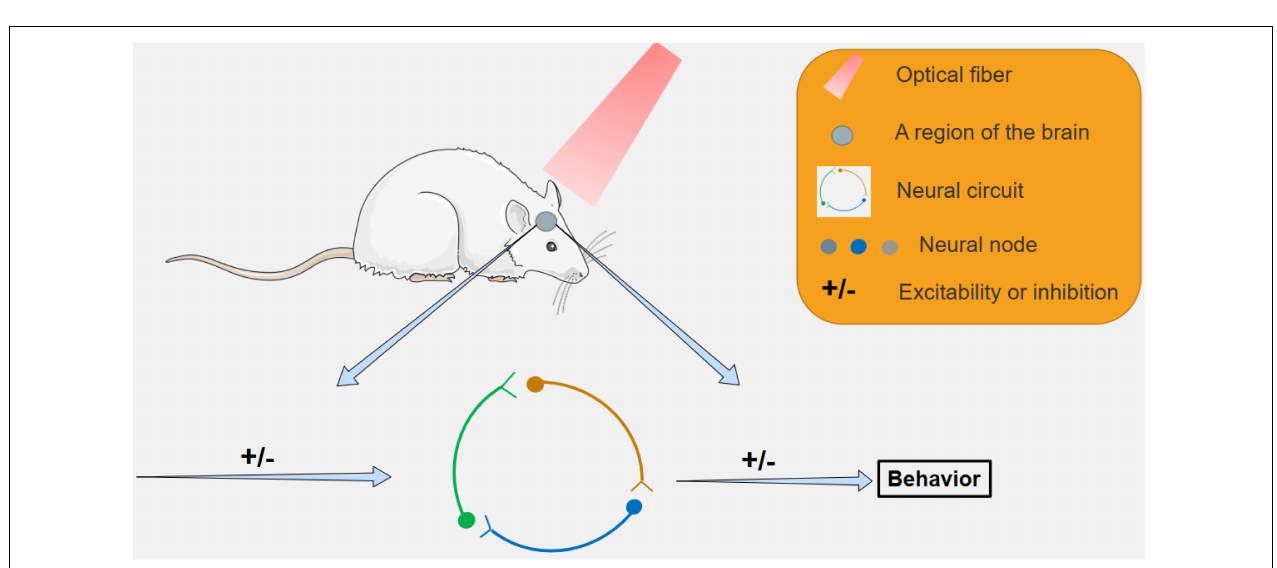
FIGURE 1 | The study of optogenetics in the field of neurons. Using optogenetics, it is possible to induce stem cell differentiation, identify cell function, and decode intercellular signaling pathways.